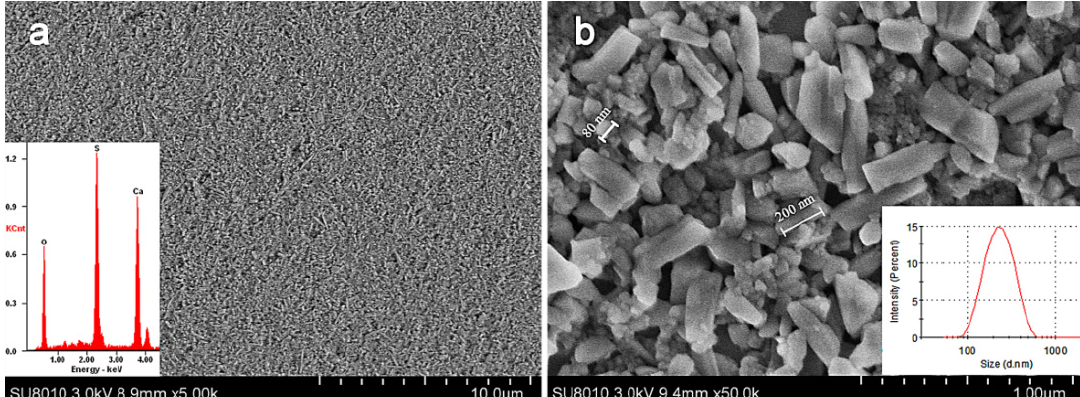
Figure 3. The SEM images of the CSH particles in the suspension liquid. ( a ) ×5000, ( b ) ×50,000.